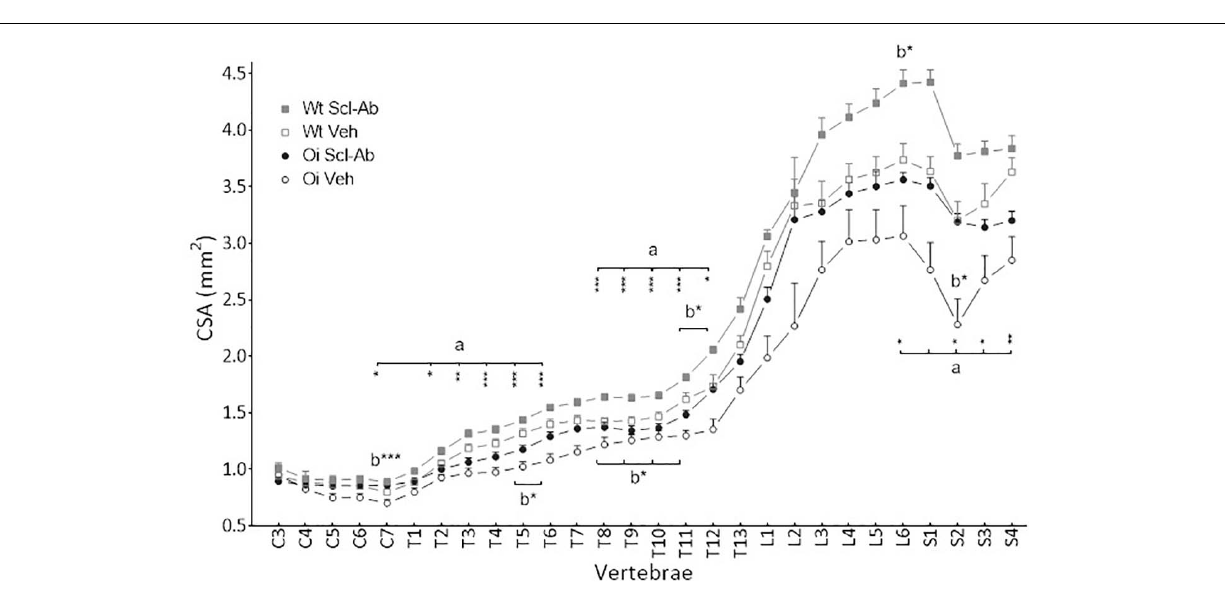
FIGURE 2 | Vertebral body cross sectional area (CSA) from C3 to S4 assessed by sagittal pQCT in male wild-type (Wt) and oim/oim (OI) mice after 9-week treatment with either Scl-Ab or vehicle (Veh.). Results are expressed as mean + SEM; a = OI Veh. versus Wt Veh.; b = Scl-Ab versus Veh., * p < 0.05, ** p < 0.01, *** p <